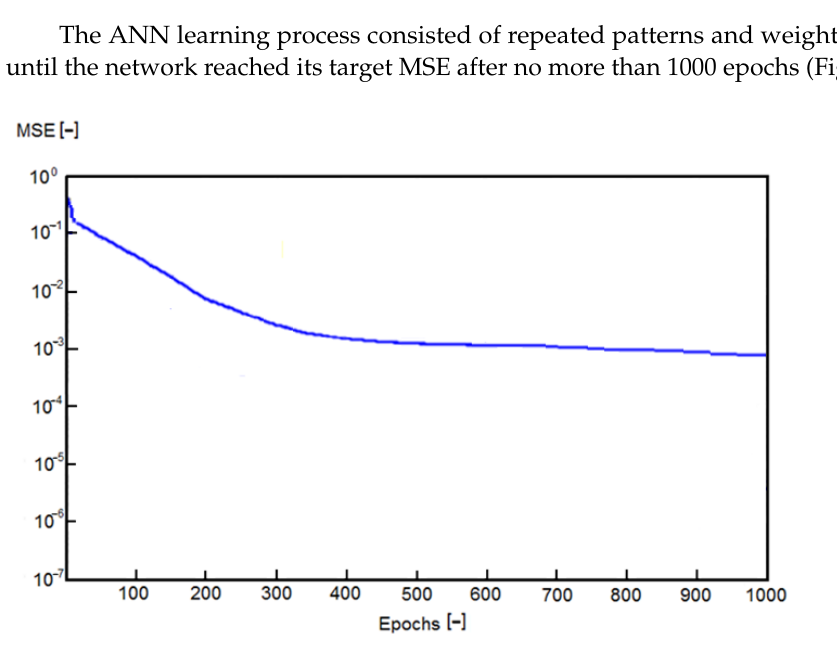
Figure 3. Values of mean square error (MSE) during learning. The best results were obtained for the network structure parameters: n = 28, m = 4, and 35 neurons in the hidden layer (i.e., MLP 28-35-4). The ANN was able to minimize the MSE for the training set data to very low values (ranging from 0.001–0.02) (Table 4, Table 5, best choice in